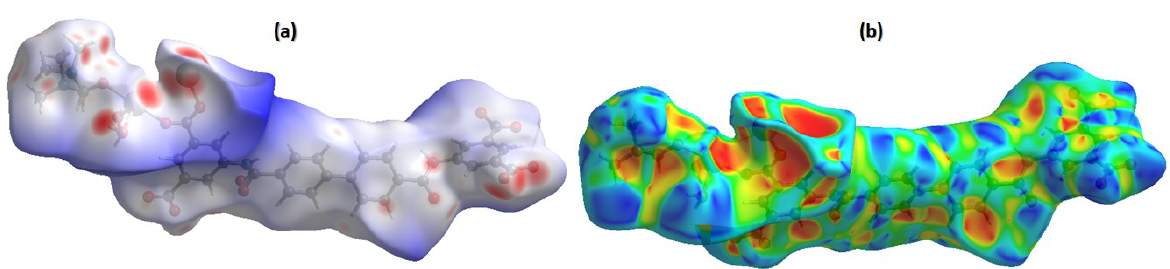
Figure 6. Hirshfeld surface plotted over d norm ( a ) for CdMOF in the range − 0.524 to 3.787 a.u. ( b ) Hirshfeld surface plotted over shape index in the range − 1 to 1 a.u.